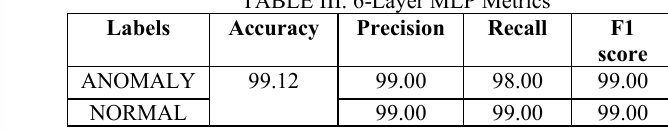
TABLE III. 6-Layer MLP Metrics